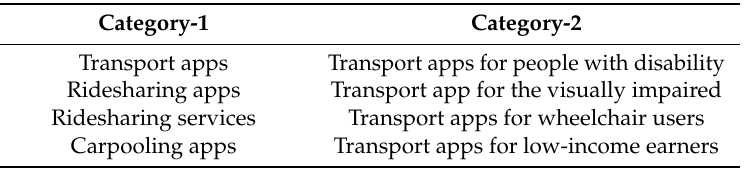
Table 1. Terms used in Google searches.